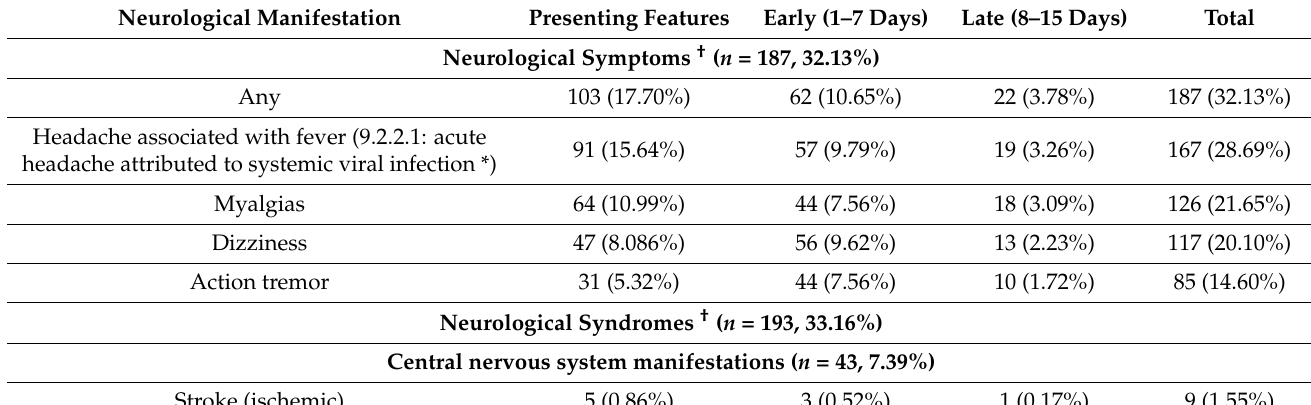
Table 3. Neurological manifestations in temporal relation to COVID-19